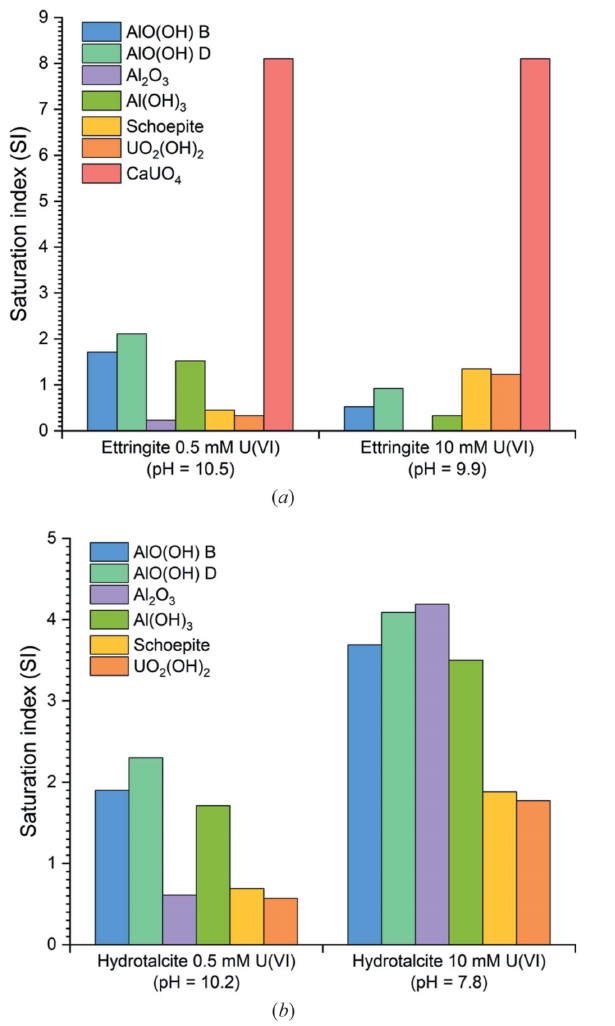
Figure 3 Geochemical modelling results showing all estimated saturated phases over the experimental pH range measured for the ( a ) ettringite and ( b ) hydrotalcite samples, in contact with 0.5 m M U VI and 10 m M U VI .